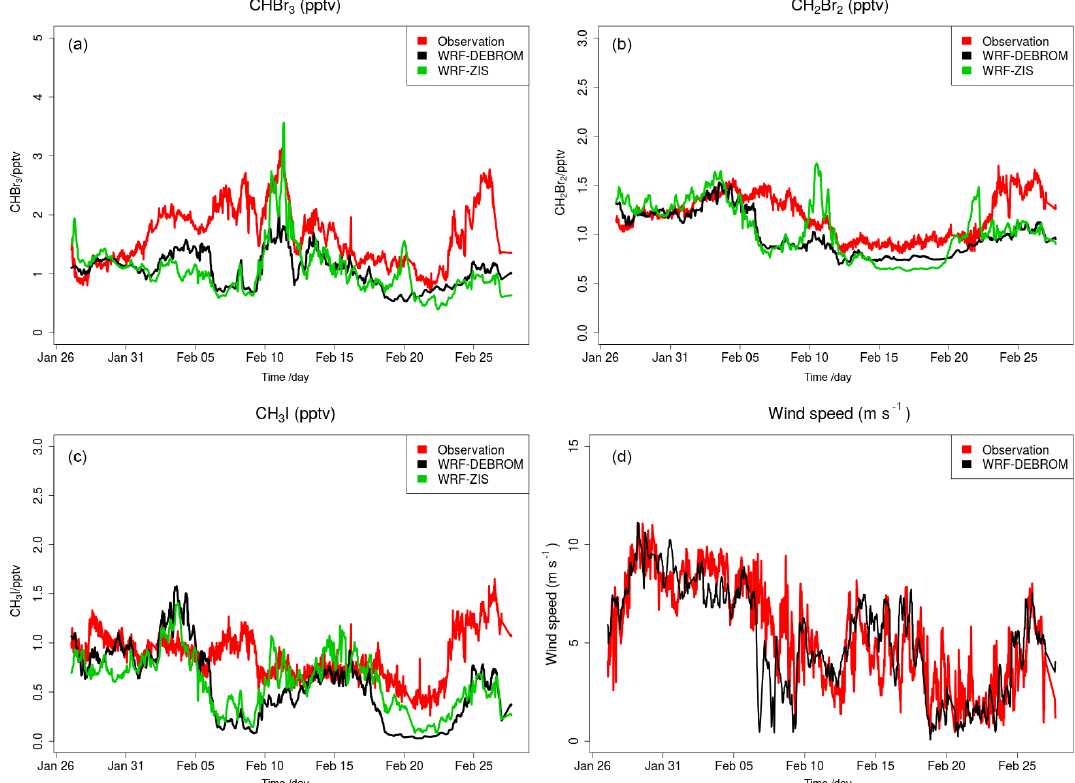
Figure 5. Time series of CHBr 3 (a) , CH 2 Br 2 (b) and CH 3 I (c) mixing rations (in pptv) for the WRF-ZIS (green line) and WRF-DEBROM (black line) runs during the period of the TORERO campaign in 2012. In panel (d) , the wind speed (ms − 1 ) of the model is shown with a black line. Measurements during the TORERO campaign are depicted with red